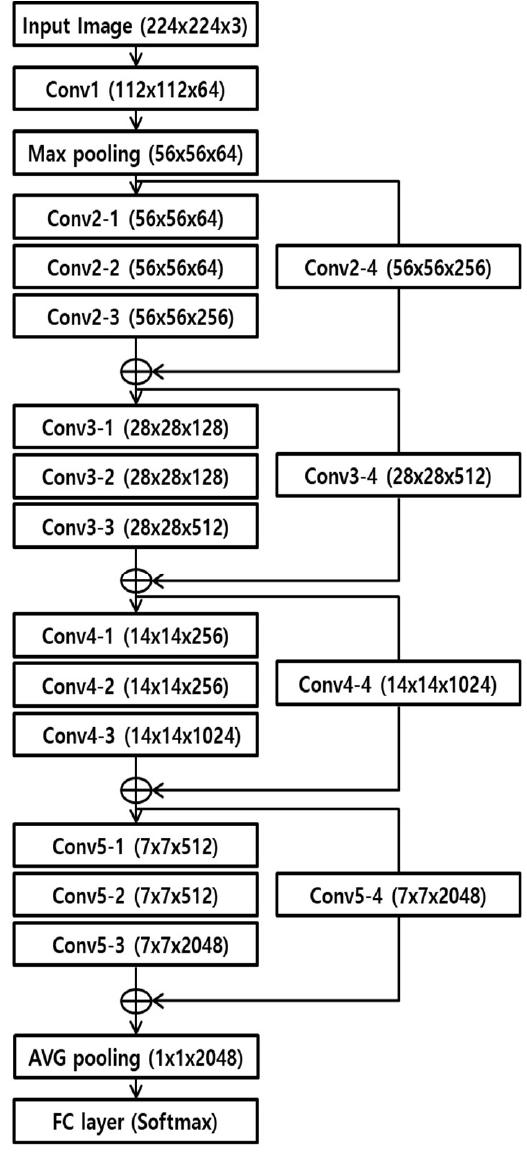
Figure 6. Convolutional neural network (CNN) structure used in our